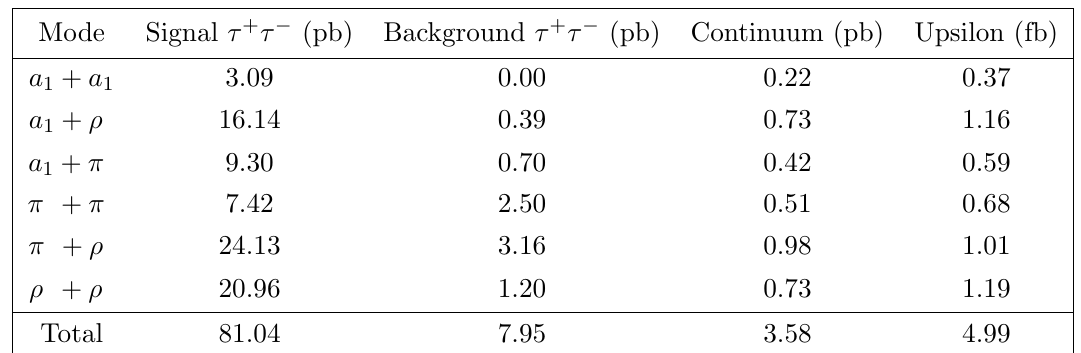
Table 1 . The e(cid:11)ective cross sections for di(cid:11)erent processes after the selection cuts, in di(cid:11)erent (cid:28) + (cid:28) (cid:0) decay modes.